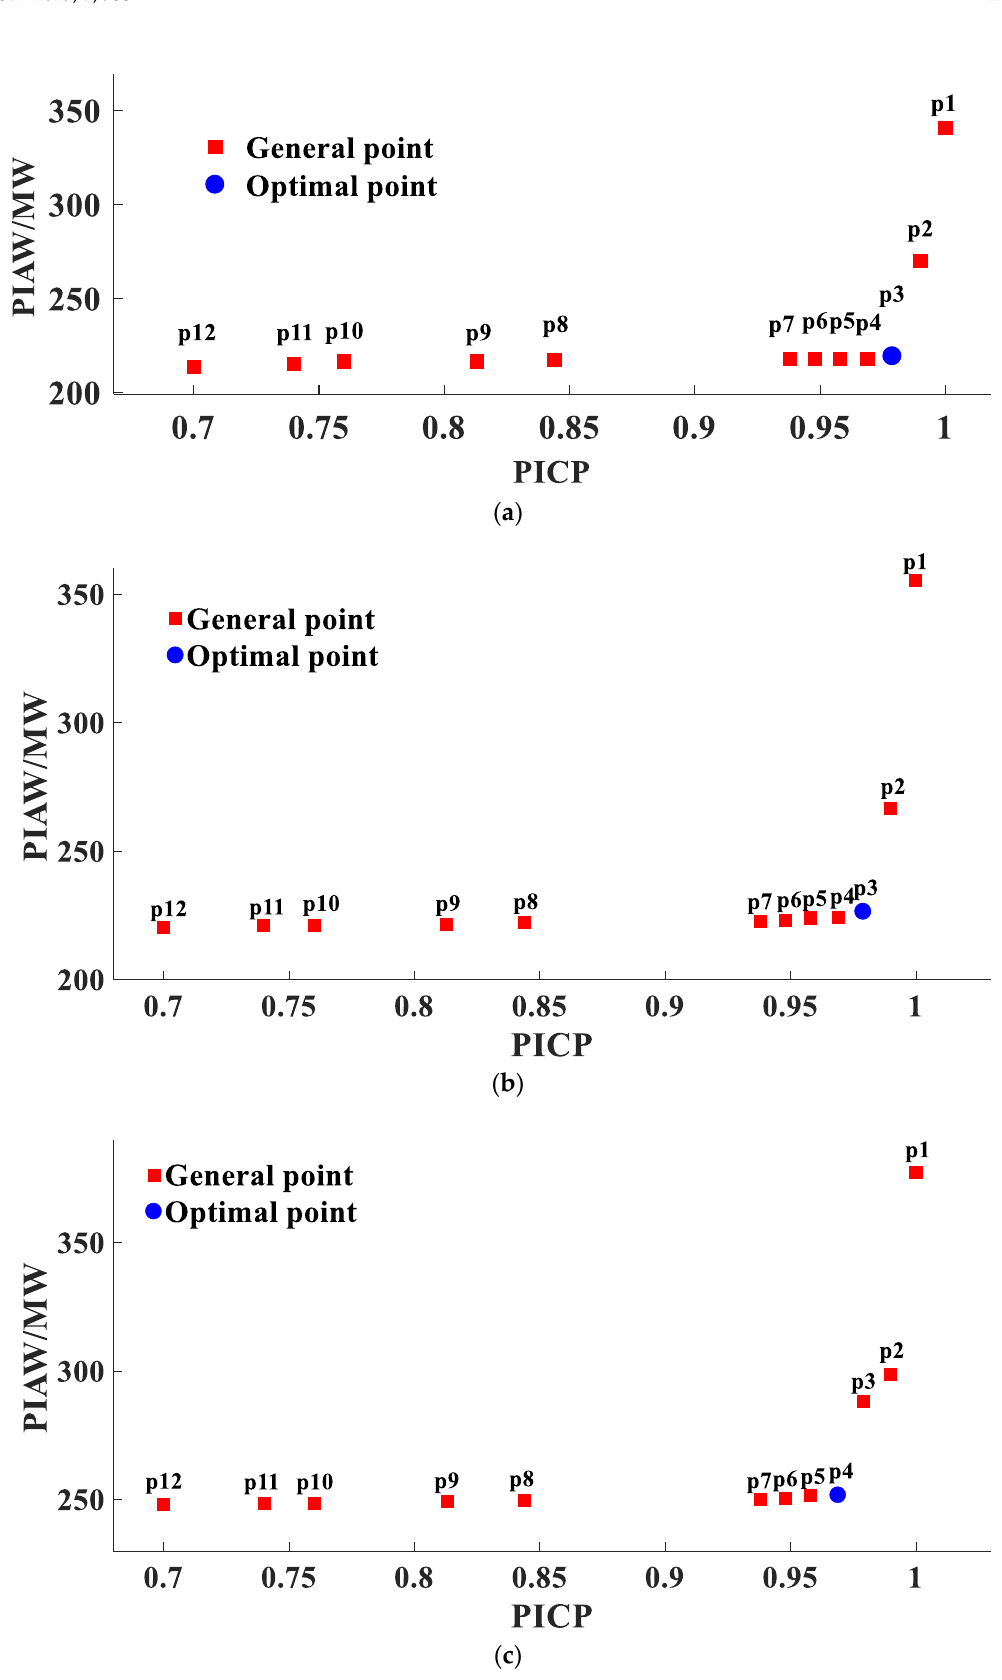
Figure 3. Pareto optimal solution set: P: point, P1: point 1, ( a ) region 1, ( b ) region 2, ( c ) region 3.